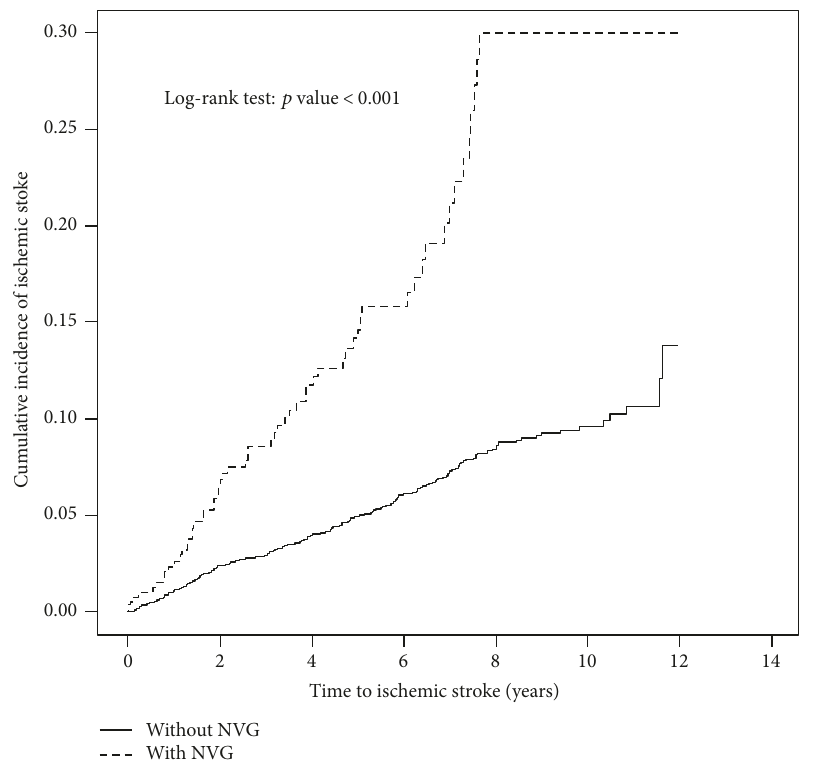
Figure 2: Comparison of the cumulative incidence of ischemic stroke between the NVG and control cohorts using the Kaplan-Meier Table 2: Comparison of the incidence density rates of stroke between patients with NVG and controls strati fi ed by demographic characteristics and comorbidities.